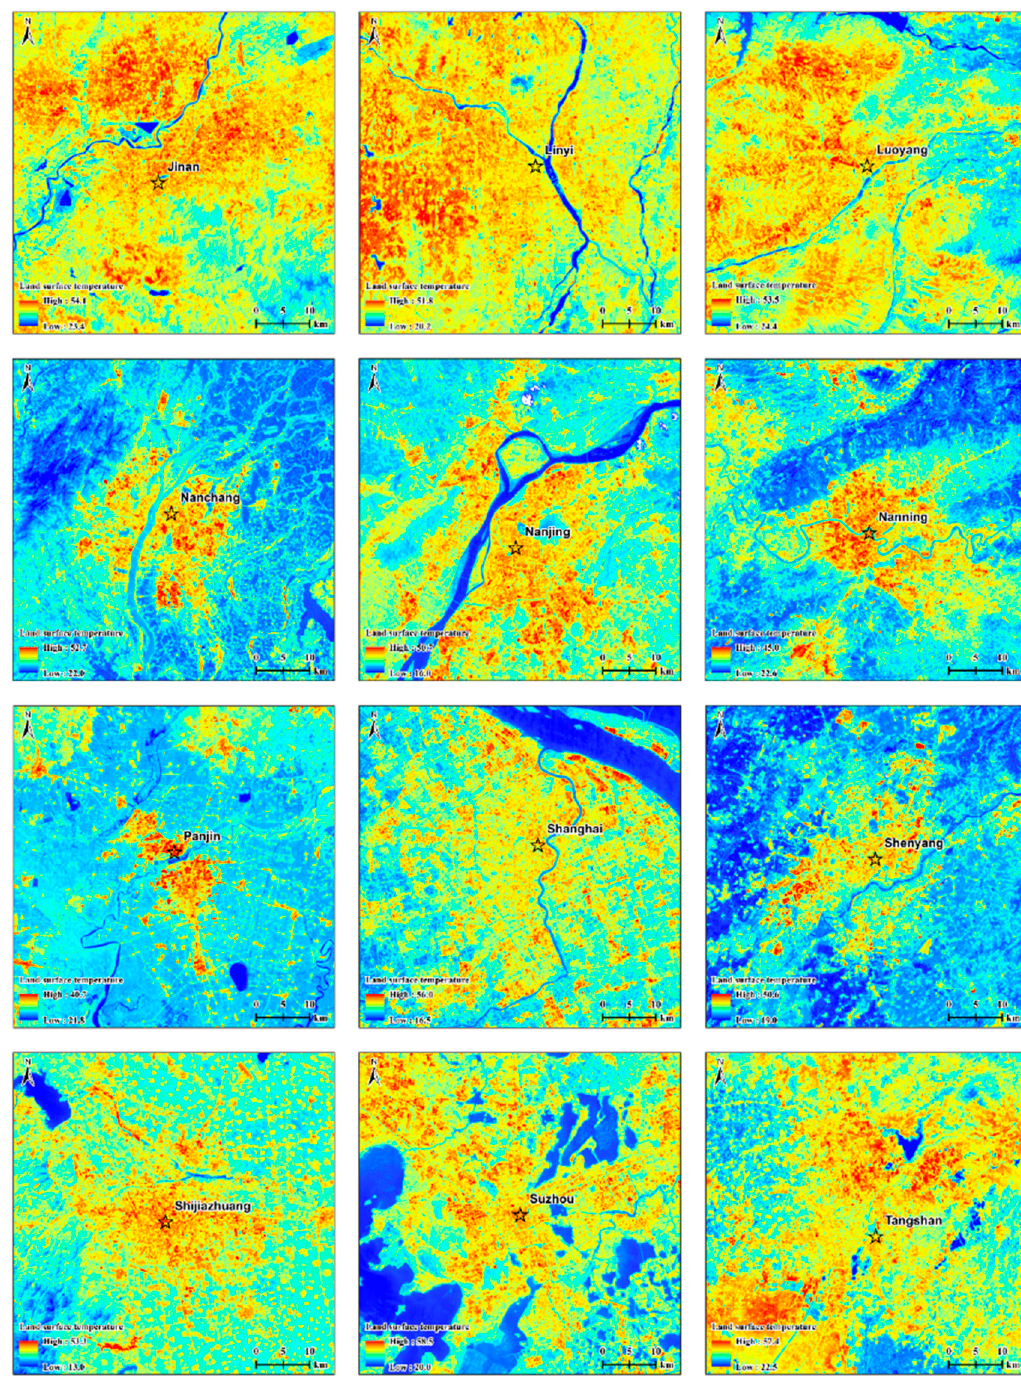
Figure A2. Map of the land surface temperature (LST) data for the 32 Chinese cities Figure A2.